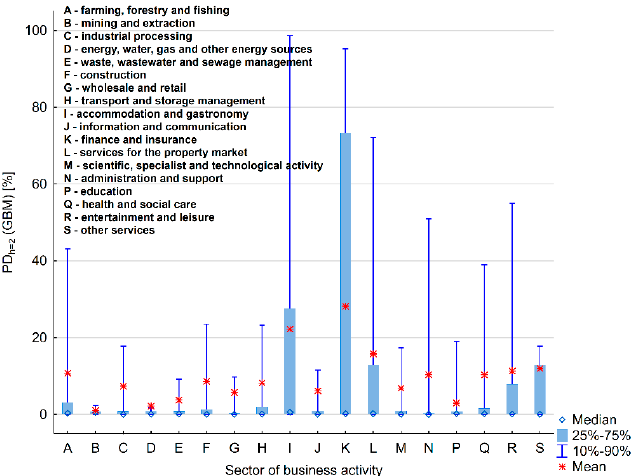
Figure 14. Descriptive statistics characterizing the probability distribution of bankruptcy (over a 2-year time horizon) for the surveyed enterprises from the Podkarpacie for various sectors of their business activities. Source: own elaboration using Statistica.